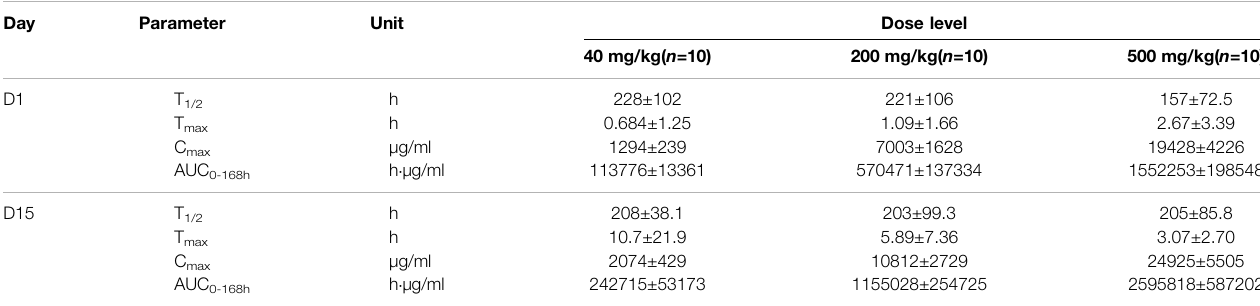
TABLE 2 | Main toxicokinetic parameters of